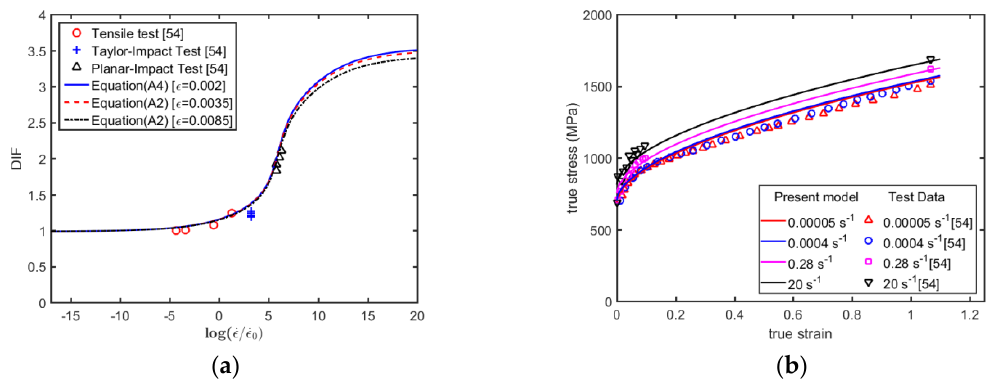
Figure A3. Comparison of the present model with the test data for 35 Ni Cr Mo V 109 high-strength steel. ( a ) DIF at different plastic strains versus strain rate at room temperature; and ( b ) true tress-true strain curves in tension.